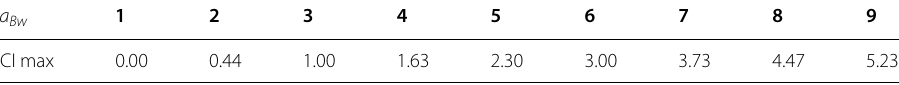
Table 1 Consistency indices for BWM (Rezaei 2015) a